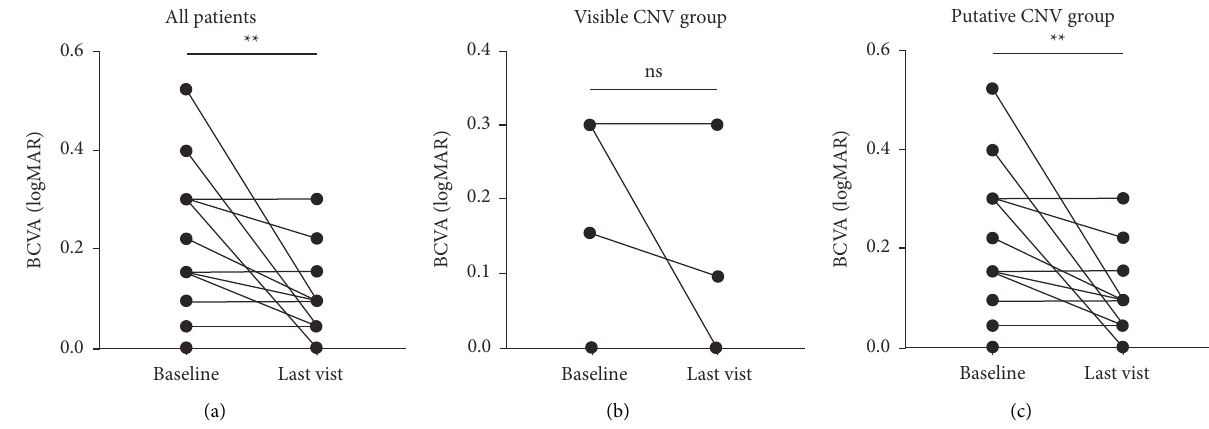
Figure 1: The changes of BCVA in CSCR patients at baseline and last follow-up after anti-VEGF treatment. (a) The changes of BCVA logMAR scale for all patients. (b) The changes of BCVA in logMAR scale in the visible CNV group. (c) The changes of BCVA in logMAR scale in putative CNV group. The data were represented as mean ± SD. CNV, choroidal neovascularization; CSCR, central serous cho- rioretinopathy; logMAR, the logarithm of minimal angle of resolution. The statistics was analyzed by paired t-test; ns, not statistically significant; ∗ P < 0 . 05 and ∗∗ P < 0 .